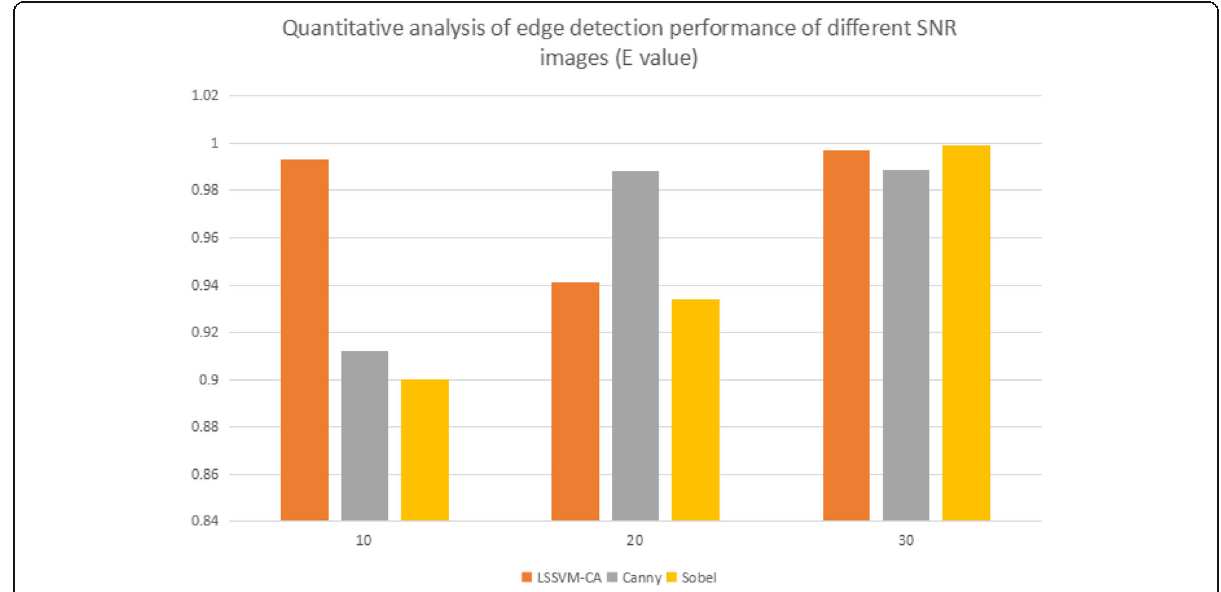
Fig. 6 Quantitative analysis of edge detection performance of different SNR images ( E